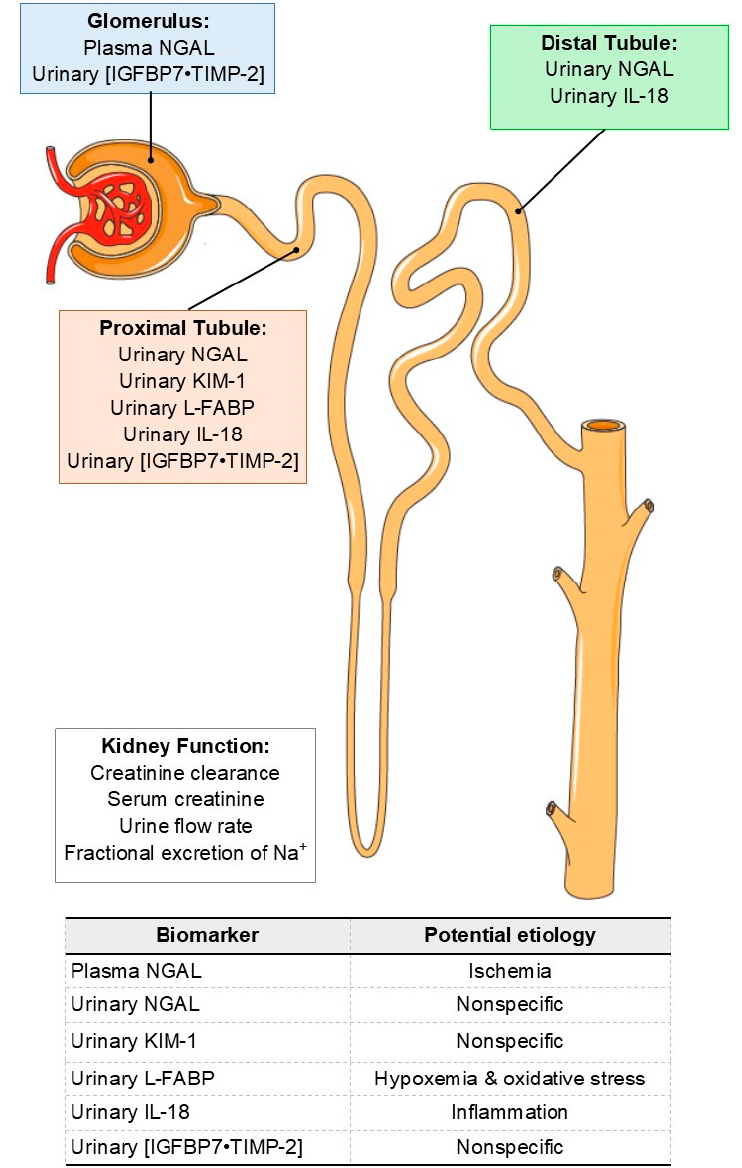
Figure 1. Top: Anatomical locations for biomarkers indicative of an increased risk of acute kidney injury (AKI) and common clinically relevant measures indicative of overall kidney function. Bottom: Potential etiology underlying increases in AKI biomarkers. Abbreviations—NGAL: Neutrophil